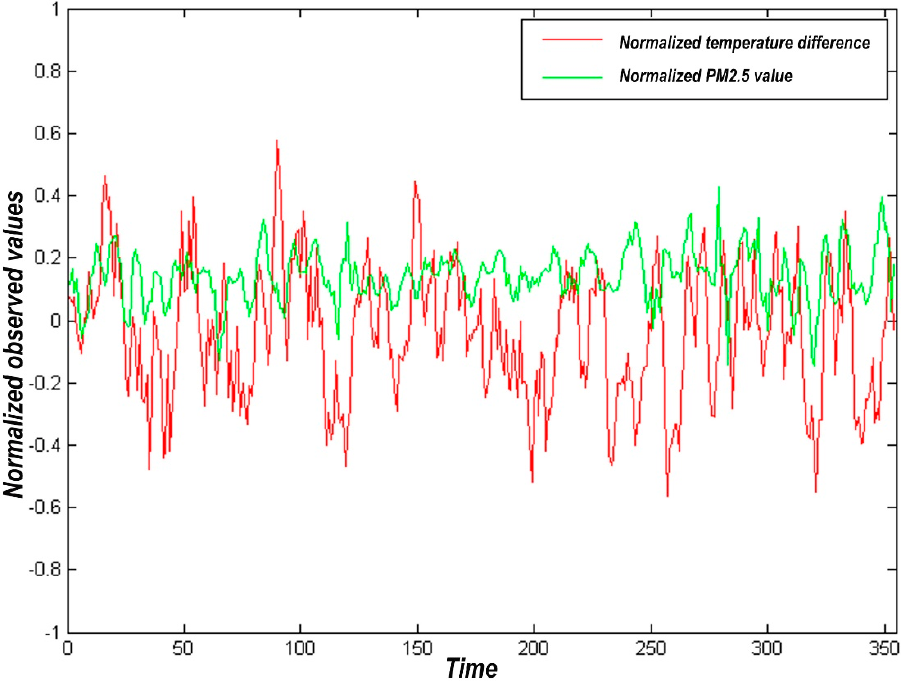
Figure 1. Correlation between temperature difference and PM2.5 difference.